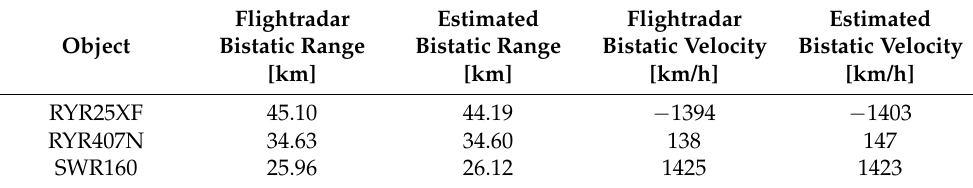
Table 2. Bistatic target parameters for the transmitter in Piatkowo—April